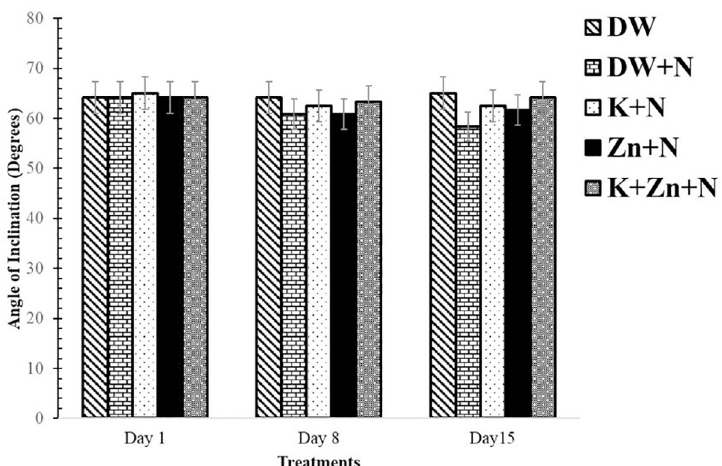
Fig 3. Effect of kaempferol and zinc on neuromuscular coordination in Wistar rats exposed to noise stress (Mean ± SEM, n = 6). Neuromuscular coordination was assessed using the inclined plane. The highest angle at which the rat could no longer stay, standing horizontally and facing any of the directions was recorded. Two trials were performed for each testing period. DW, Deionized water; K, Kaempferol; ZnG, Zinc gluconate; N, Noise.